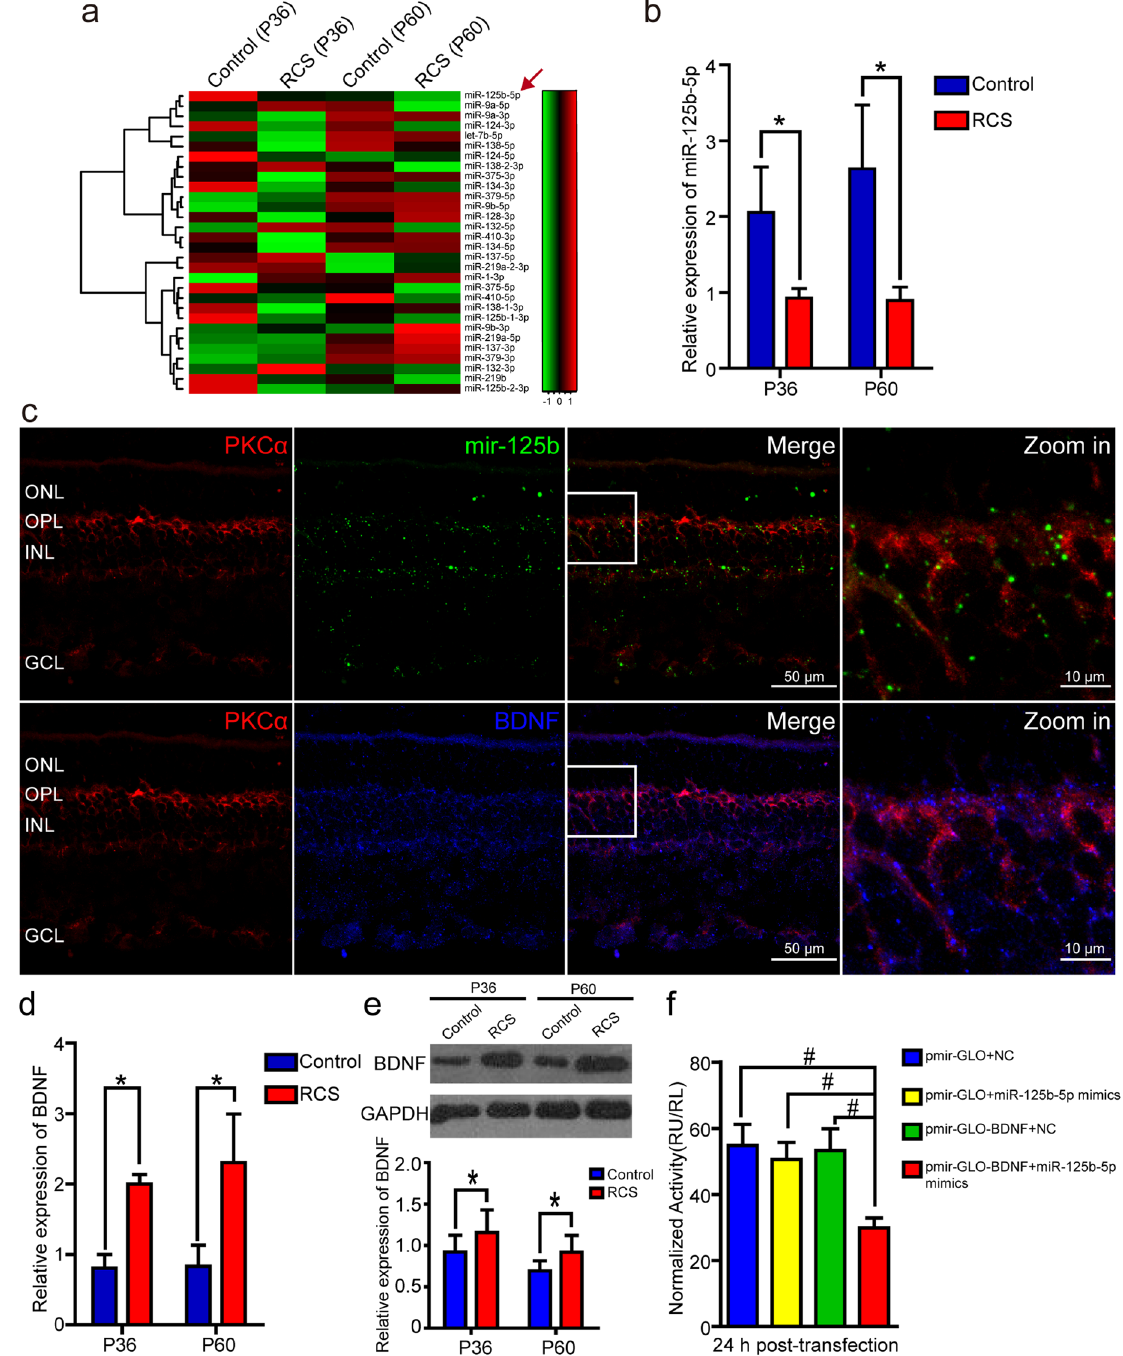
Figure 3. The expression of miR-125b-5p in RBCs and regulation of BDNF mRNA expression. ( a ) Heat map showing the relative expression of 30 synapse-relevant microRNAs in the retinae of the control and RCS rats at P36 and P60. The red arrow indicates where the relative expression of miR-125b-5p in the retinae of RCS rats decreased compared with the control retinae. ( b ) RT-qPCR data showing the relative expression of miR-125b-5p in the retinae of control and RCS rats at P36 and P60 (n = 3). ( c ) Staining for mir-125b, BDNF and PKC α in the retinae of P36 RCS rats. In situ hybridization with mir-125b probe (green) was followed by immunostaining with anti-PKC α (red) and anti-BDNF (blue) antibodies, as described in Methods. ( d ) RT- qPCR analysis of the mRNA expression of BDNF in the retinae of control and RCS rats at P36 and P60 (n = 3). ( e ) Western blot analysis of BDNF expression in the retinae of the control and RCS rats at P36 and P60 (n = 3). GAPDH was used as a loading control. For original blot images, please see Supplementary Fig. 11. ( f ) The normalized luciferase activity of pmirGLO (as a control) and pmirGLO-BDNF-transfected cells after negative control (NC) or miR-125b-5p mimic treatment (n = 3). ONL: outer nuclear layer; OPL: outer plexiform layer; INL: inner nuclear layer; GCL: ganglion cell layer. Bars show means; error-bars, SD; * p < 0.05; # p <